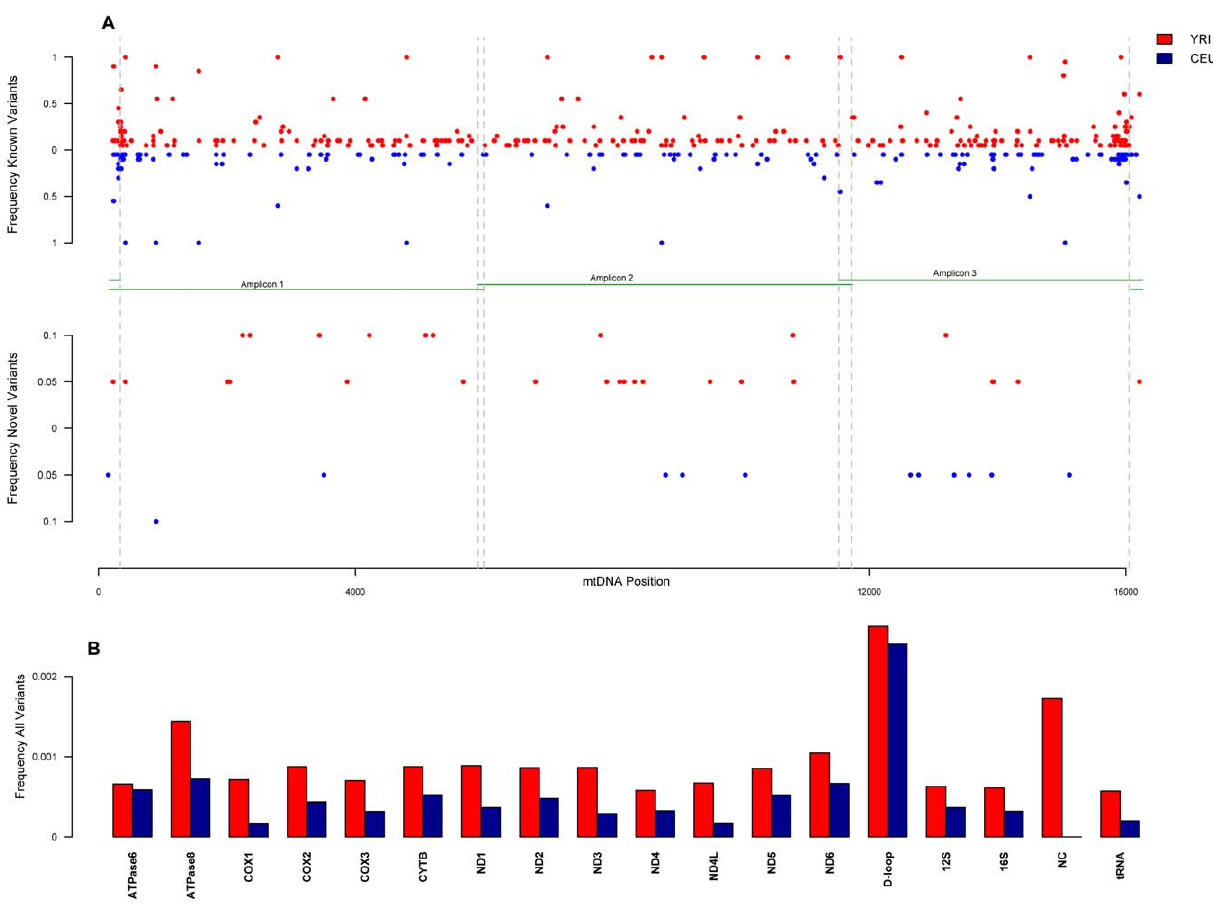
Figure 2. A. Frequency of polymorphic sites by population across the mitochondrial genome. The top portion of the figure shows the physical locations of the amplicons with overlap across the mtgenome; red and blue dots represent YRI and CEU samples, respectively. Frequency of known polymorphic sites for all samples by population showed on top, and frequency of novel polymorphic sites by population on bottom. The term ‘known’ refers to sites that are listed in mtDNA databases and the term ‘novel’ refers to sites that have not been previously described. B . Frequency of Polymorphic sites per mitochondrial genomic region . Red and blue bars represent YRI and CEU, respectively. Frequency was calculated by dividing the number of polymorphic sites found in each region by the length of that region and then dividing again by the sample size. Each site in a region was counted only once.